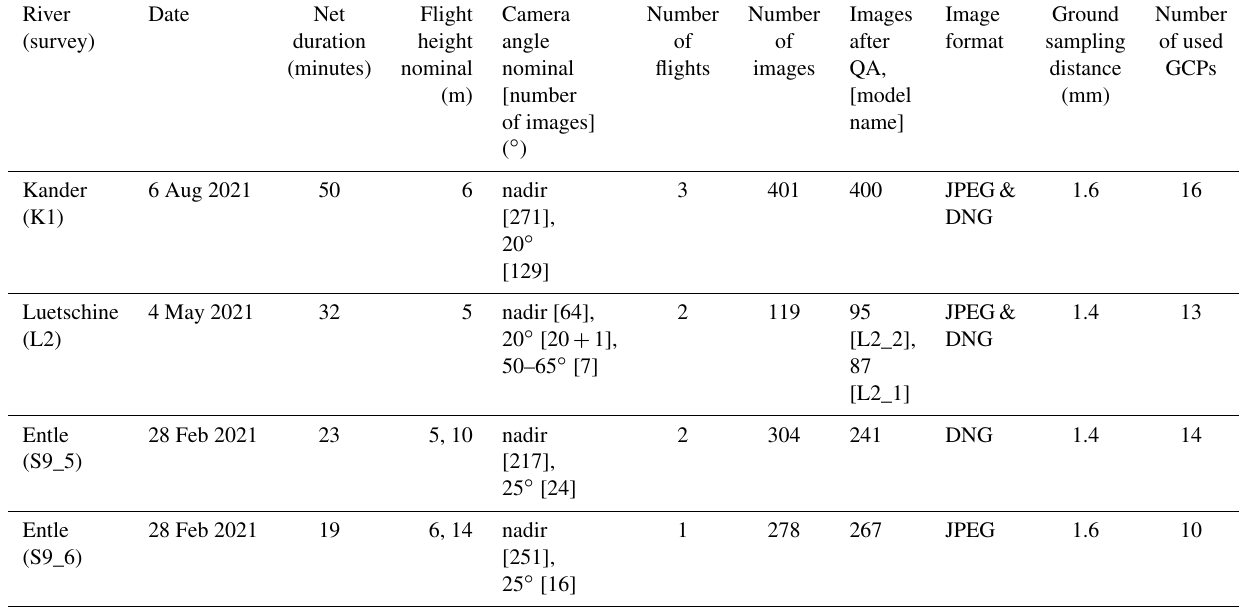
Table 1. Summary of the field surveys. QA: quality assessment. Here we removed images that were (i) blurred, (ii) hard to align because of an insufficient depth of field due to camera angles that were too oblique, or (iii) under- or overexposed. GCP: ground control point. River Net